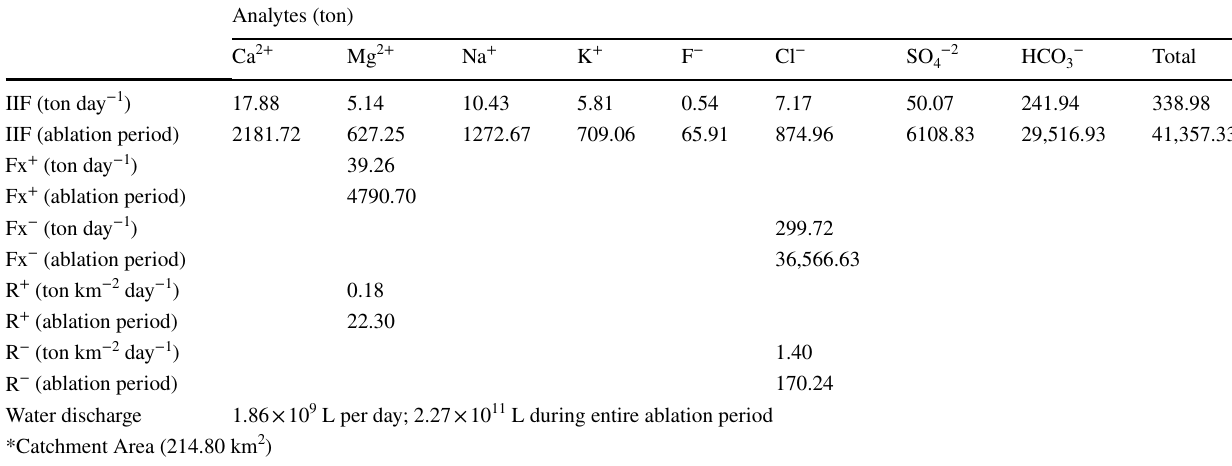
Table 6 Estimation of daily and entire ablation periods Individual Ion Flux (IIF), cation flux (F + ), anion flux (F − ), cation denudation rate (R + ) and anion denudation rate (R − ) of the Chaturangi glacier catchment in year 2016